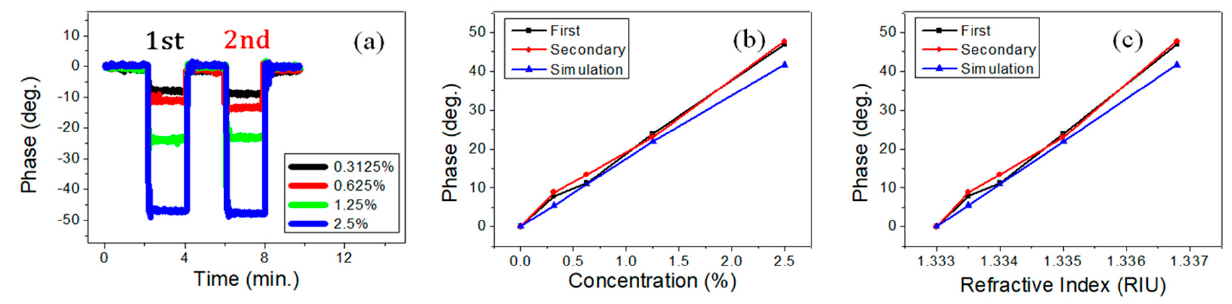
Figure 3. Measurements of NaCl solution concentrations with a single polyethylene terephthalate (PET) at 40° incident angle. ( a ) Phase variations by alternately exchanging the pure water and the different NaCl solution. ( b ) Phase versus NaCl concentration. ( c ) Phase versus the refractive index.